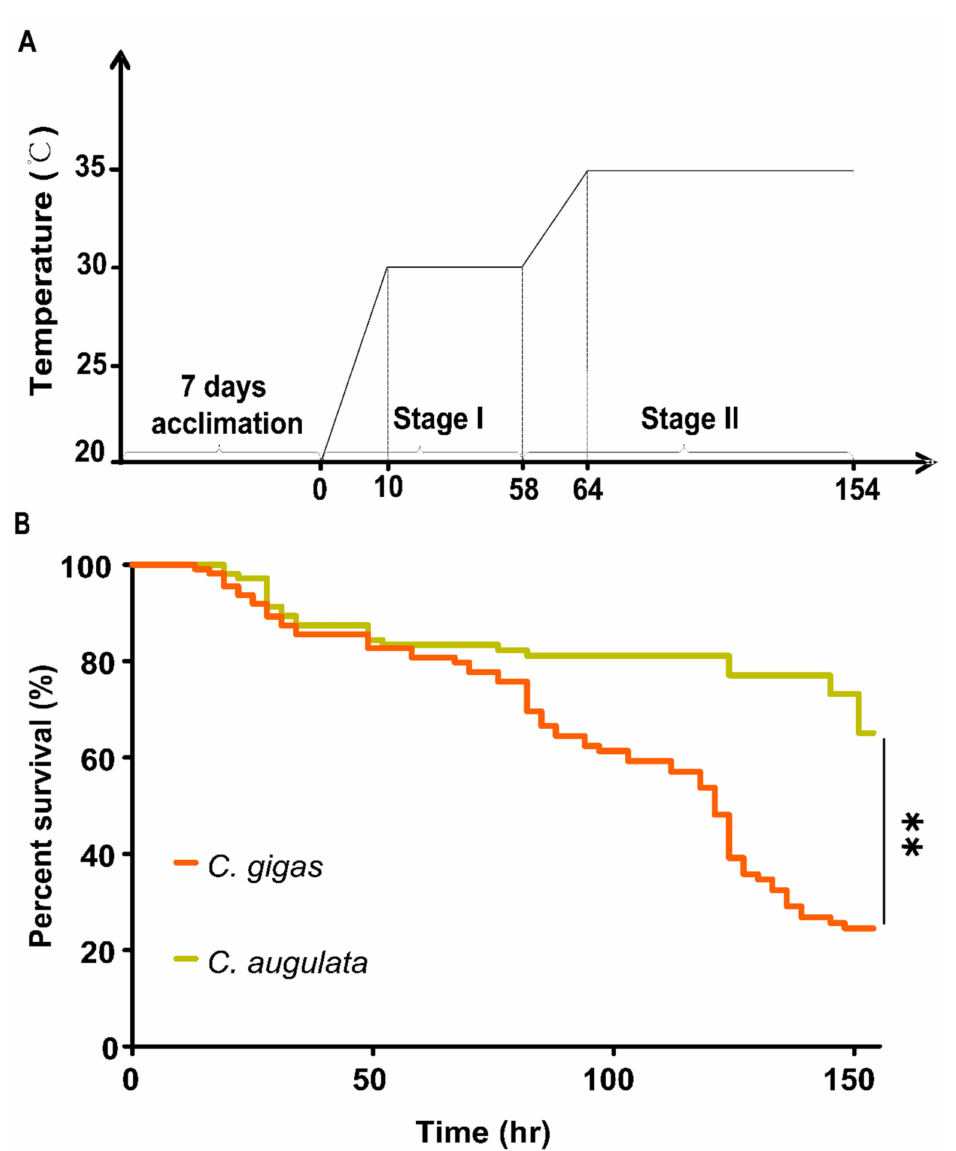
Figure 4. Chronic heat stress experiment and survival analysis. ( A ) Schematic presentation of the chronic heat stress experiment; ( B ) Mortality comparison between two oyster species. A number of 200 juvenile oysters per group were used for the experiment. ** indicates statistical significance ( p < 0.01)